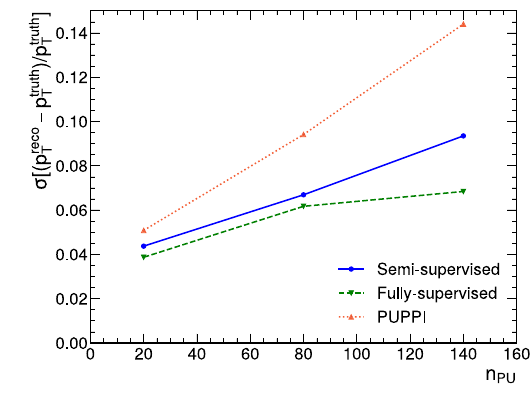
Fig. 5 Resolutions of jet mass (left) and jet p T (right) as a function of n PU